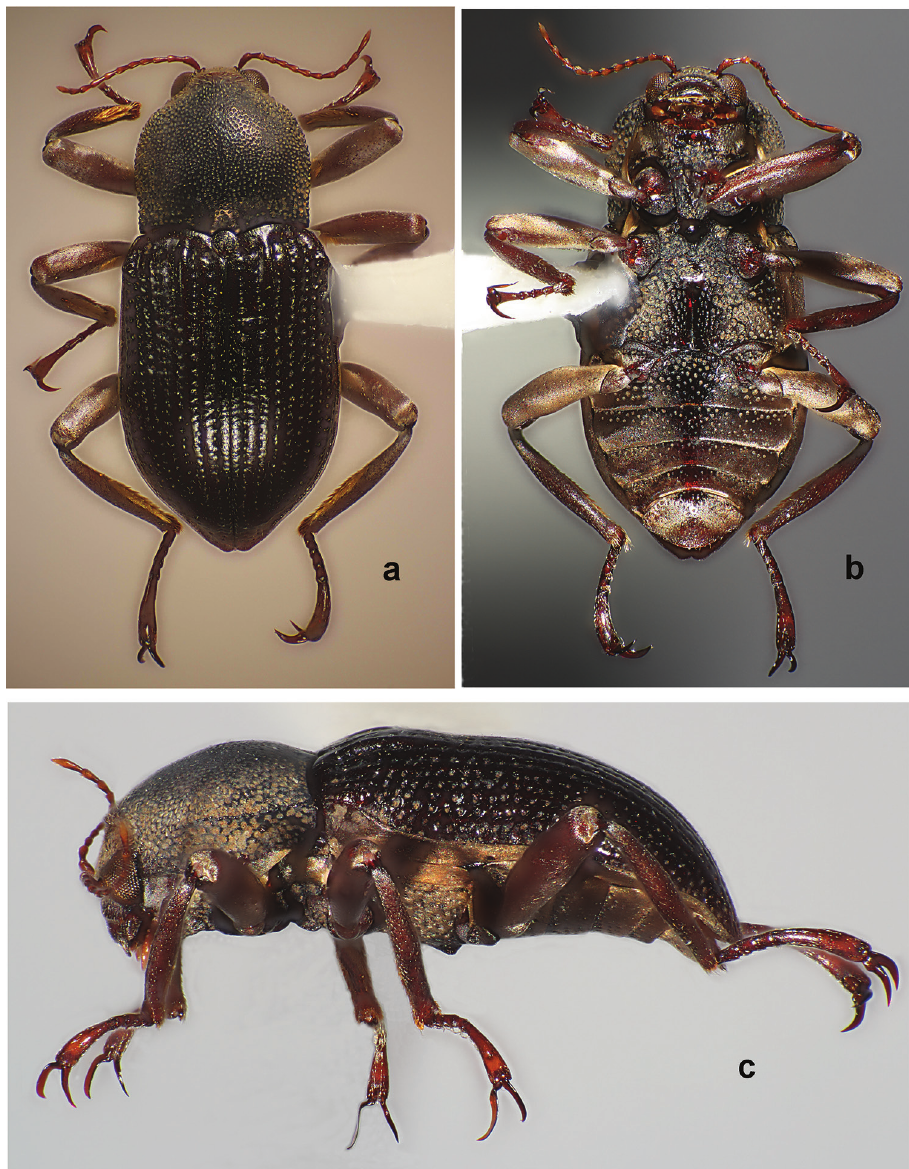
Figure 1. Amazonopsis theranyi sp. n., paratype male from Peru, length 4.15 mm a Dorsal habitus b Ven- tral habitus c Lateral